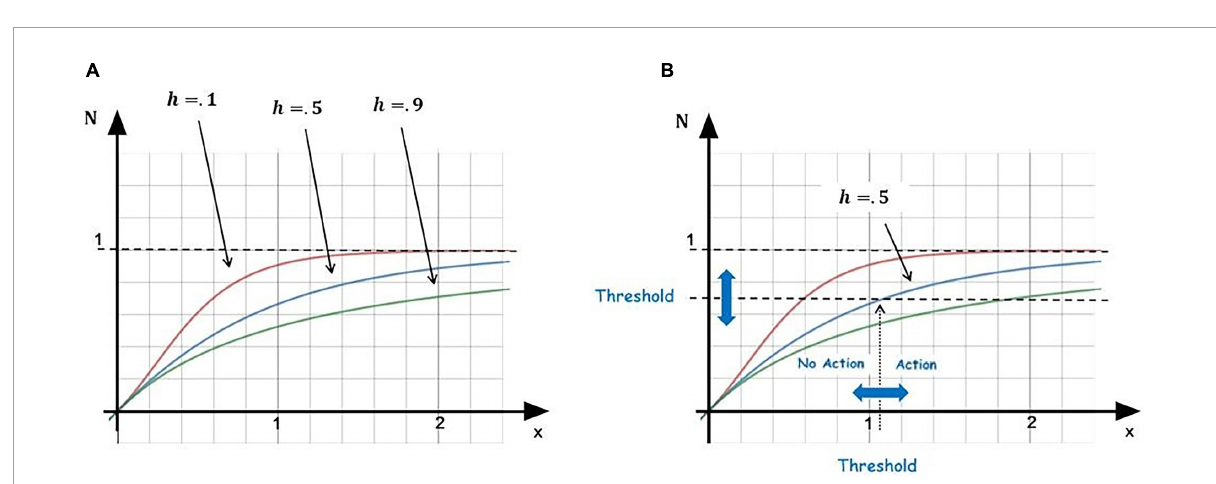
FIGURE4 Calculation of the need function, N . (A) Three different levels of parameter h are shown (0.1, 0.5, 0.9) to illustrate that an increasing h reduces the steepness of the curve. (B) A threshold is set so that, when N is greater than the threshold, the agent can perform an attachment or caregiving behavior. Here, the case of h = 0 . 5 and corresponding threshold is